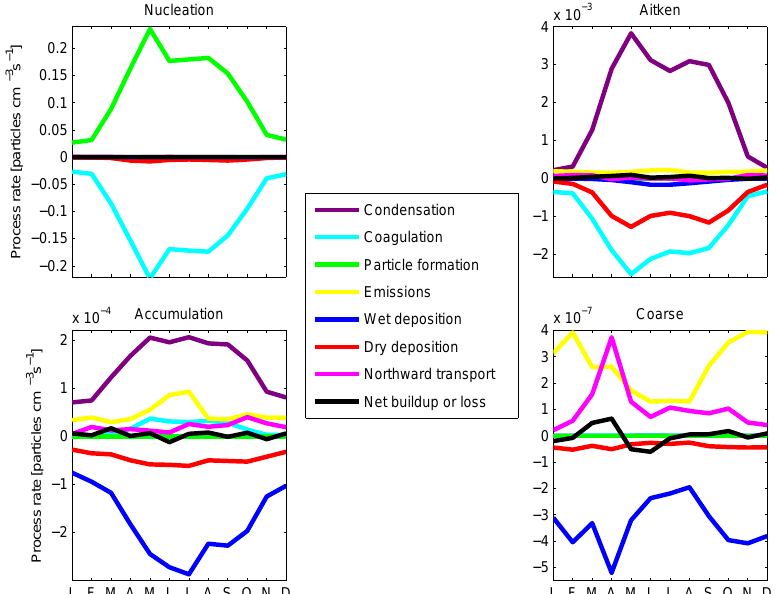
Figure 11. Monthly- and regional-mean aerosol number process rates for the entire troposphere north of 50 ◦ N for simulation NEWSCAV + COAG. Processes considered for each of four size ranges are nucleation, emissions, coagulation, condensation, wet and dry deposition, transport across 66 ◦ N, and net regional accumulation or loss rates. The aerosol size ranges are nucleation ( D p < 10nm), Aitken (10 <D p < 100nm), accumulation (100 <D p < 1000nm), and coarse ( D p >